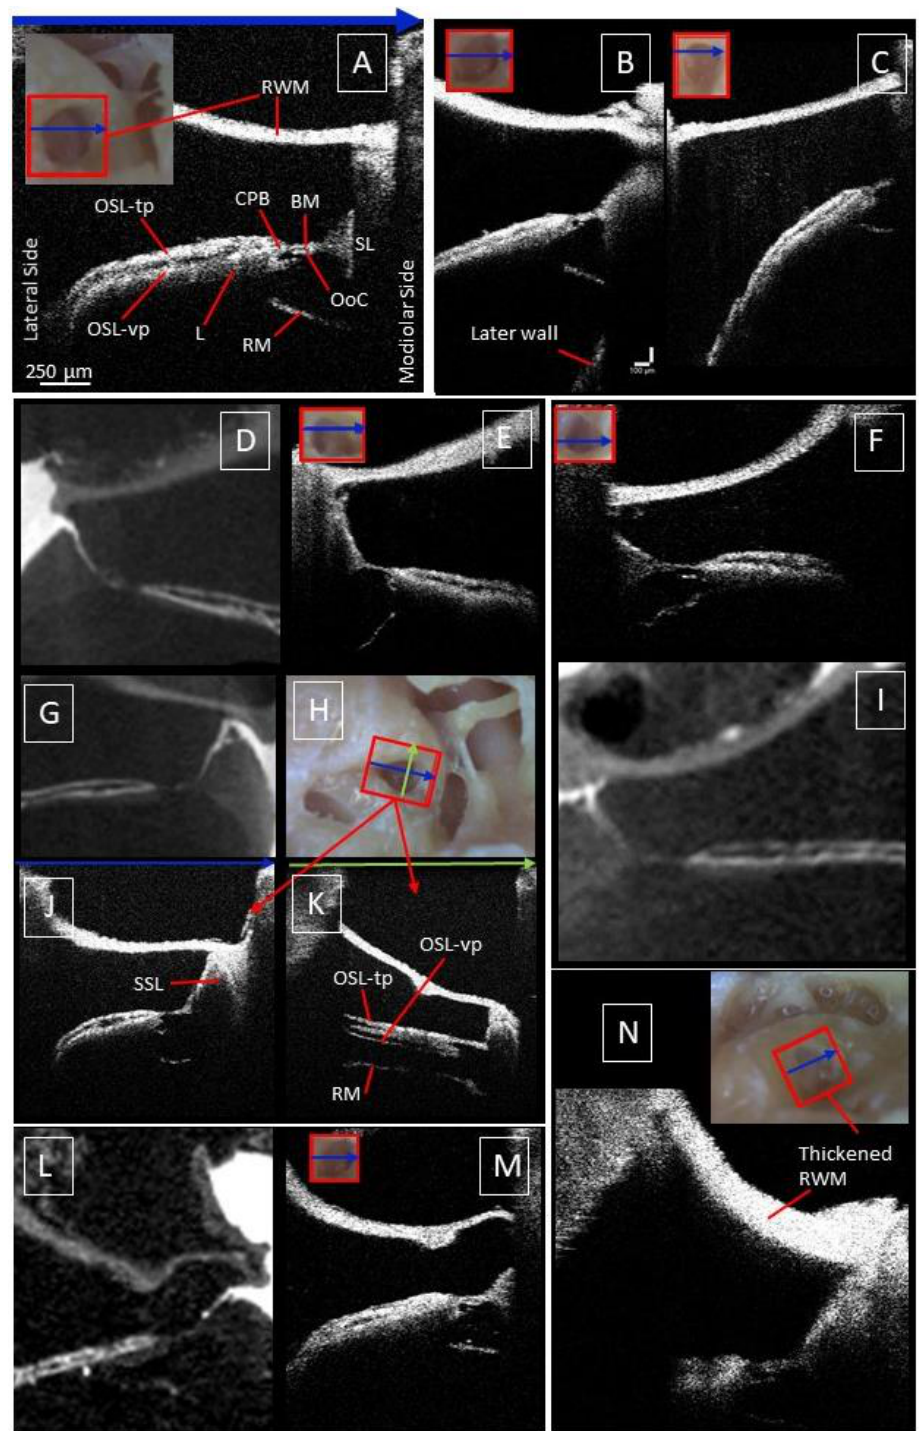
Figure A3. ( A ), the blue arrow on top of the OCT cross-section corresponds to the blue or green arrow at the RWM. In Figure ( B ), a small part of the lateral wall is visible. In ( C ), the BM and RM are shadowed towards the lateral wall. Figure ( D ) is the corresponding microCT image of Figure ( E ). Figure ( F ) corresponds to Figure ( I ), while Figure ( G ) corresponds to Figure ( J ), with the microscopic view and cross-section in the x-direction (green arrow) indicated in Figures ( H , K ), respectively. Figure ( L ) corresponds to the OCT cross-section in ( M ). Figure ( N ) includes both the microscopic view and corresponding OCT image. A-scan rates for OCT images from A to N: 76 kHz, 10 kHz, 76 kHz, 10 kHz, 10 kHz, 76 kHz, 76 kHz, 10 kHz, and 10 kHz.